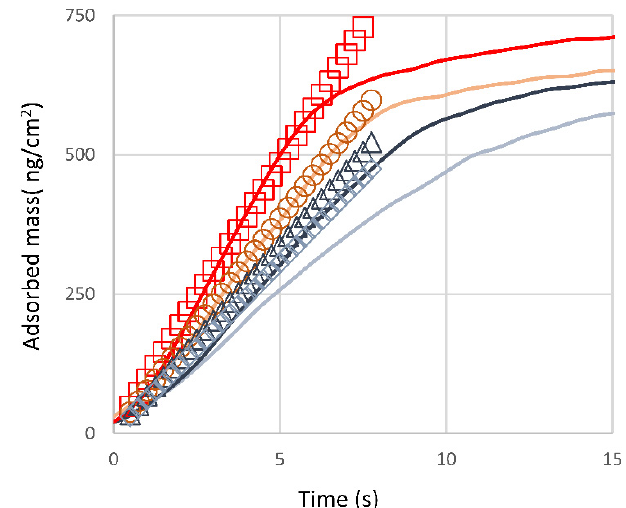
Figure 6. Comparison of the experimental and theoretical molecular transport rates at the array elements. Solid lines: experimental results for one array column obtained with Nav adsorbing on gold. Open symbols: calculated Γ ( x,t ) , where x specifies the distance between the inlet and the array element.